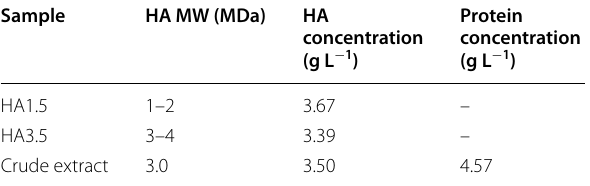
Samples were provided by BIOMENTUM SAPI de CV (Guadalajara, Mexico)